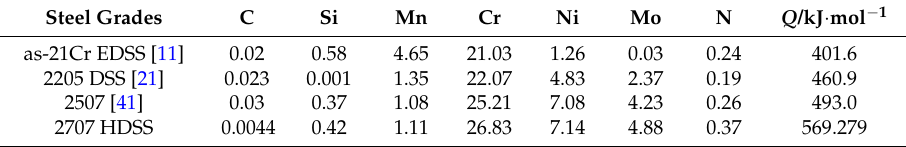
Table 1. Chemical composition and apparent activation energy of duplex stainless steel (DSS)/wt %